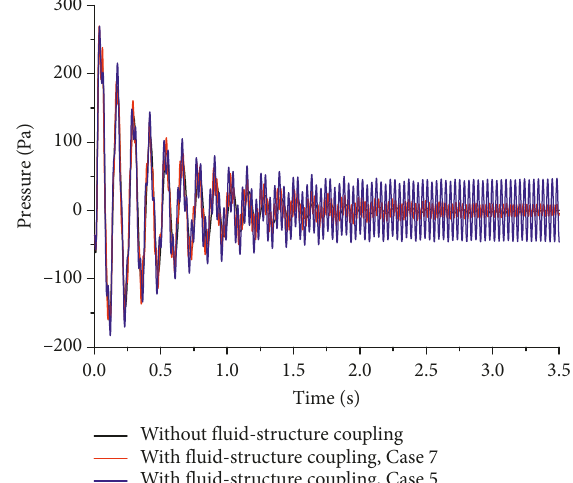
Figure 12: Pressure fluctuations of MP2 with and without fluid- structure